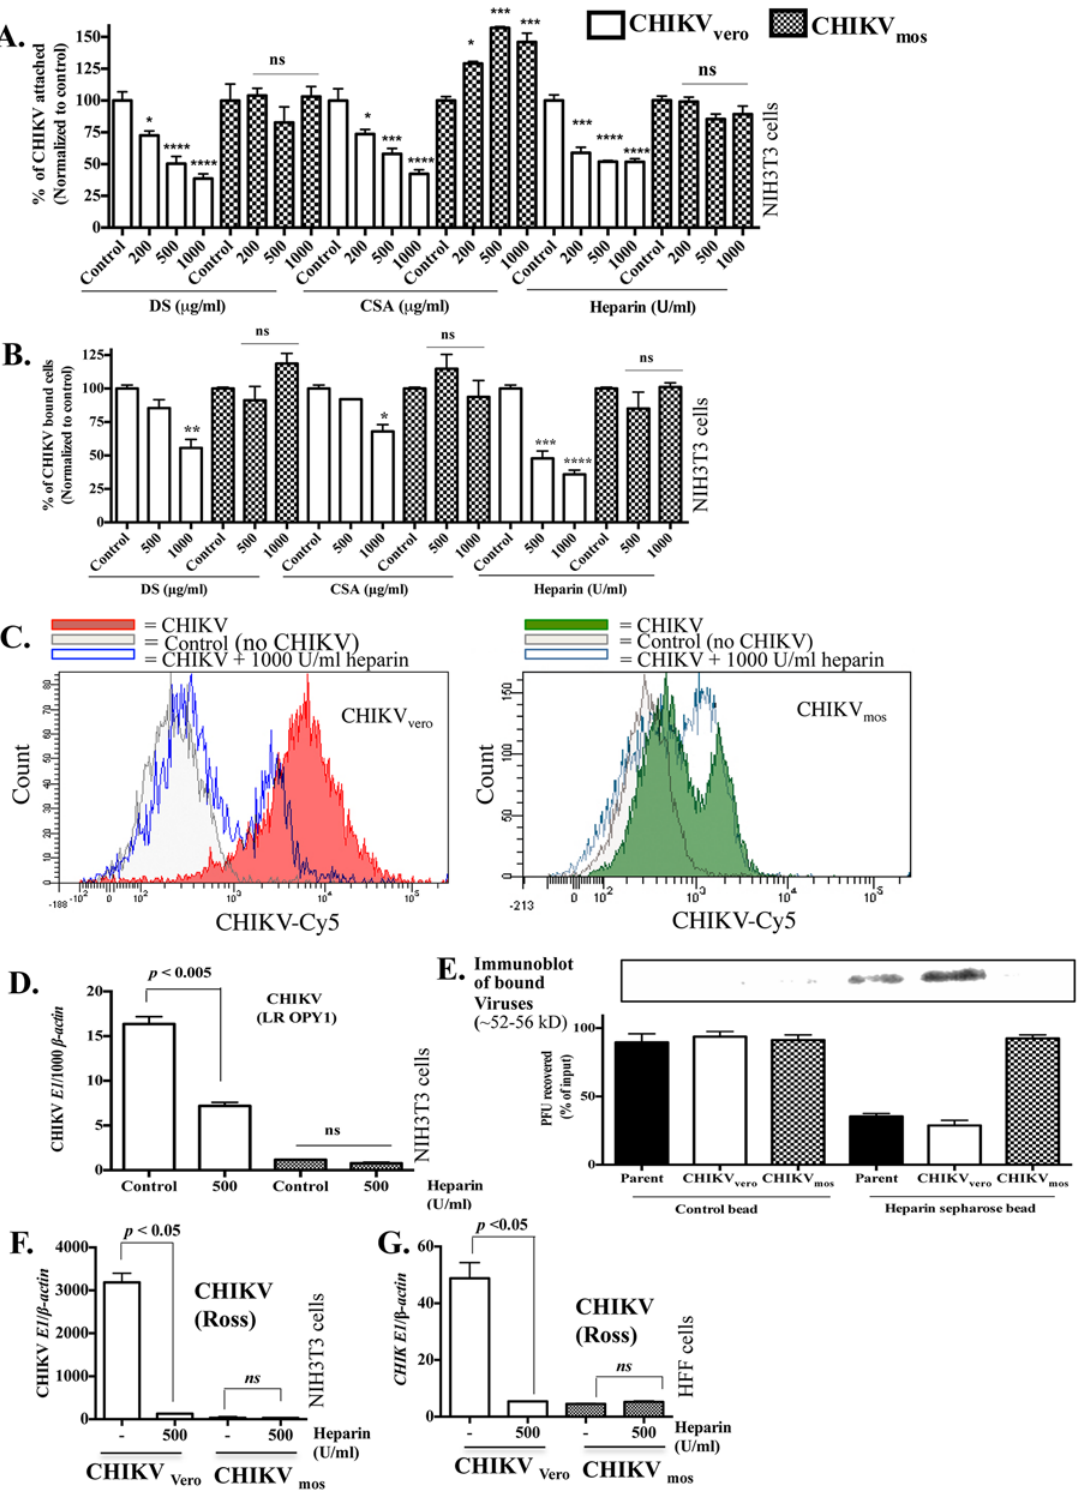
Fig 6. CHIKV vero , but not CHIKV mos , binds to cell surface glycosaminoglycan receptors. (A) Equal PFUs of CHIKV vero or CHIKV mos (Ross strain) were pre-incubated with the indicated soluble GAGs at 37°C for 1 h. The virus-GAG complexes were added to NIH3T3 cell monolayer (MOI = 1) and incubated at 4°C for 1 h and the GAGs neutralization of viral attachment was measured by RT-qPCR. Data were normalized to controls without GAG treatment. (B)